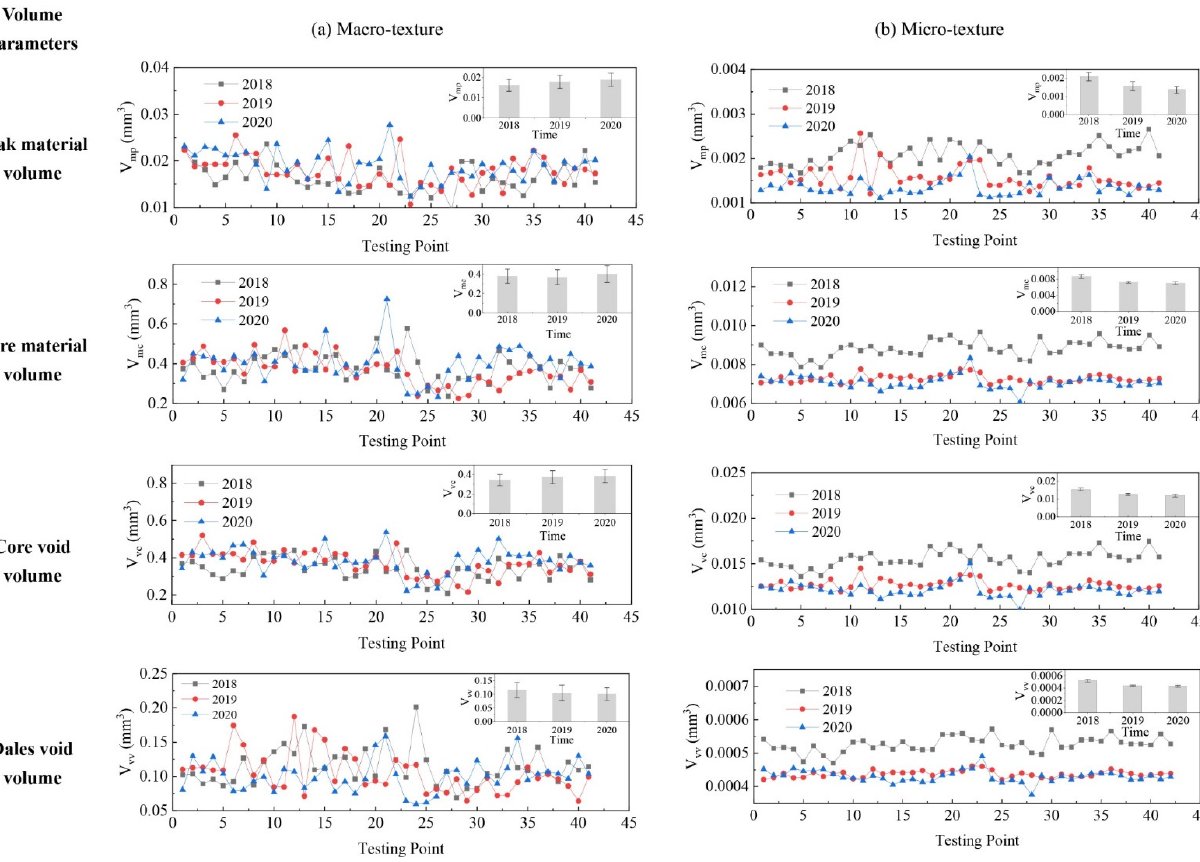
Figure 13. Pavement texture variations via volume parameters: ( a ) Macro − texture, and ( b ) Micro − texture.